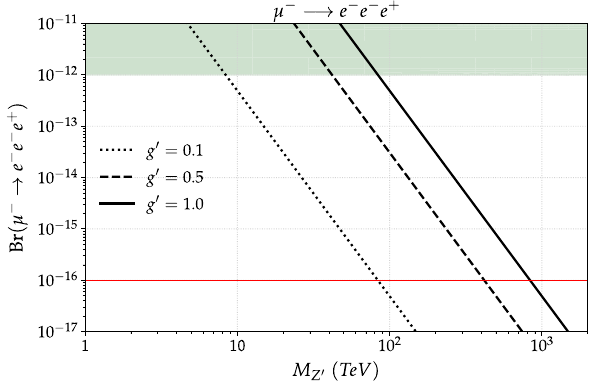
Fig. 5 Bounds to the neutral gauge boson mass M Z (cid:2) as predicted in Model D9 from Z (cid:2) contributions to the lepton flavour violation decay μ − → e − e − e + . The plot shows the branching ratio of the decay as function of the Z (cid:2) mass for various values of the gauge coupling g (cid:2) . Bothaxisareinlogarithmicscale.Dotted,dashedandsolidblackcurves correspond to U ( 1 ) (cid:2) gauge couplings: g (cid:2) = 0 . 1, 0 . 5 and 1 respectively. The shaded region is excluded due to the current experimental bound: Br (μ − → e − e − e + ) < 10 − 12 . The red horizontal line represents the estimated reach of future μ → 3 e